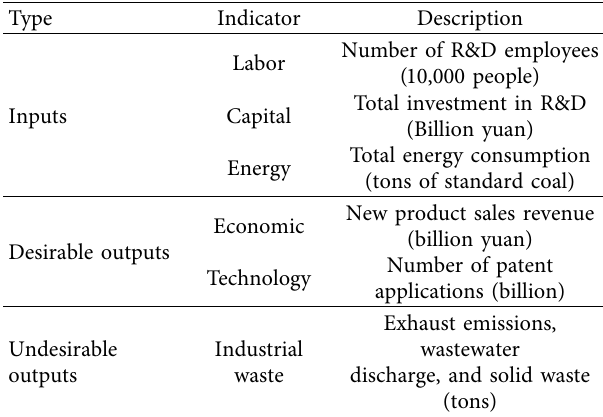
Table 1: Evaluation indicator system of green innovation efficiency in